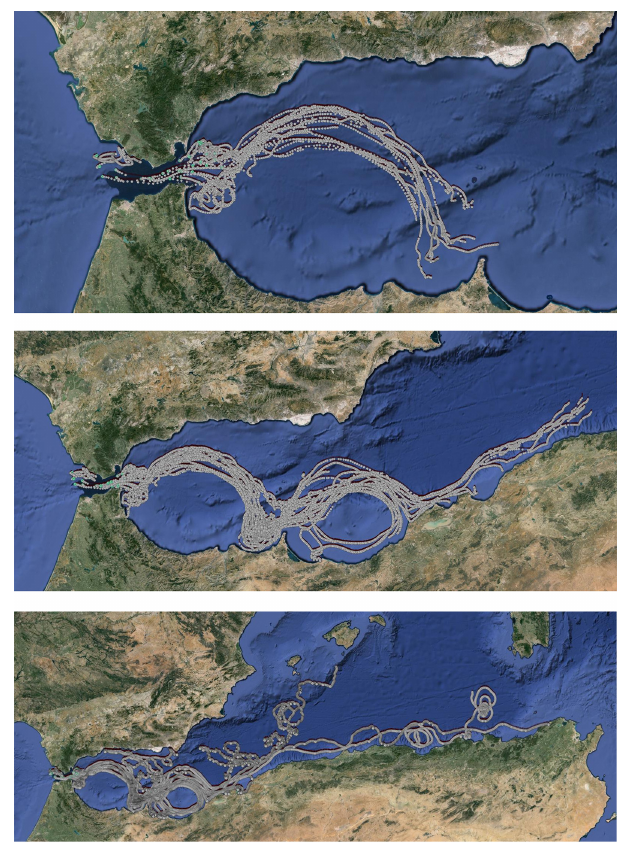
Figure 4. Trajectories of the MEDESS-GIB drifter buoys at differ- ent dates after deployment: (a) 9/13/2015 ( + 4days), (b) 9/25/2015 ( + 14days), (c) 12/9/2015 ( +